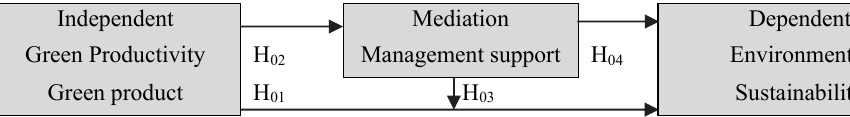
Fig. 1. The proposed model